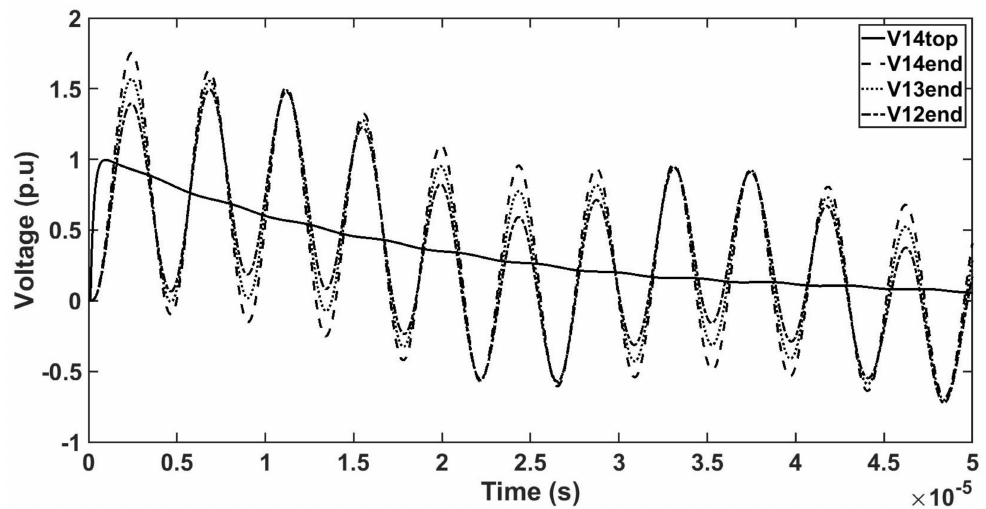
Figure 17. Surge voltage waveforms for grounded shield placement between layer 14 and 13 of HV winding under SLI.